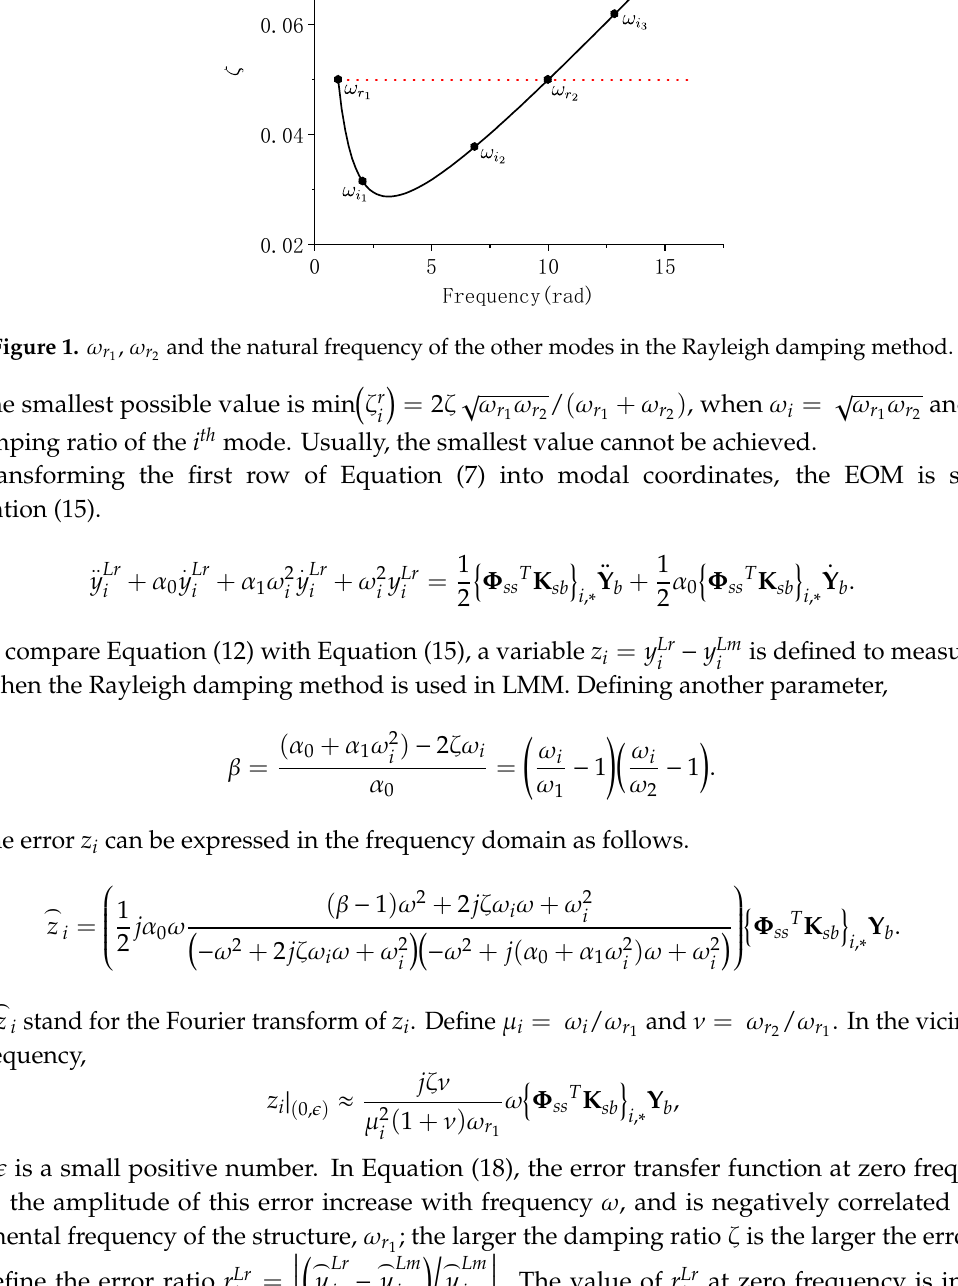
ω ω r 1 , r 2 and the natural frequency of the other modes in the Rayleigh damping method. , (cid:2033) (cid:3045) and the natural frequency of the other modes in the Rayleigh damping method. Figure 1. (cid:3117) (cid:3118)